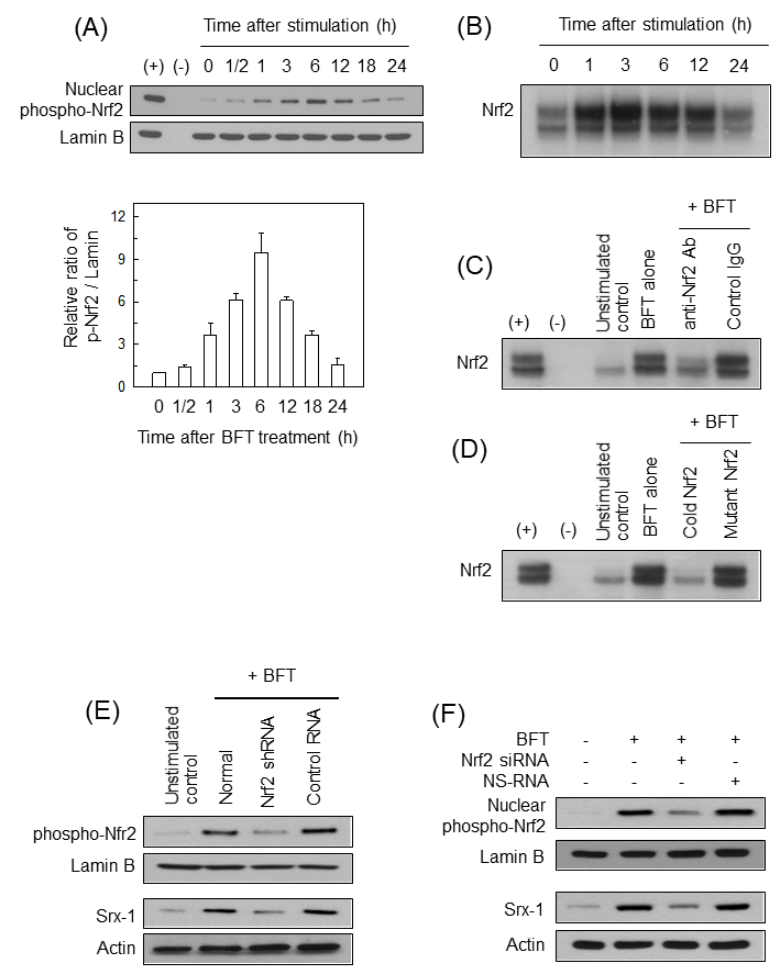
Figure 4. Effects of Nrf2-inhibition on Srx-1-expression in BFT-exposed HCT 116 cells. ( A ) BFT (300 ng/mL) was added to HCT 116 cells for the indicated periods of time. Nuclear protein expression of phospho-Nrf2 and lamin B was examined by western blot. Positive controls (+) were obtained from cells that were treated with 20 µM of sulforaphane for 2 h. Bottom panel shows densitometric analysis for expressed proteins. Values represent the relative densities of each protein compared with lamin B (mean ± SD, n = 3); ( B ) BFT (300 ng/mL) was added to HCT 116 cells for the indicated periods. Nrf2 DNA binding activity was assessed by EMSA; ( C ) HCT 116 cells were treated with BFT (300 ng/mL) for 6 h and nuclear extracts were obtained. Supershift assays using nuclear extracts were performed using anti-Nrf2 Ab and IgG isotype control Ab; ( D ) HCT 116 cells were treated with BFT (300 ng/mL) for 6 h. Nuclear extracts were added a 100-fold excess of the unlabeled probe (cold probe) or a mutant probe to the reaction, after which radiolabeled probes were added. After then, EMSA was performed identical to ( B ); ( E ) HCT 116 cells were transfected with shRNA against Nrf2 or control RNA. BFT (300 ng/mL) was added to each group for 6 h (phospho-Nrf2, top panels) or 18 h (Srx-1, bottom panels). Nuclear protein expression of phospho-Nrf2 and lamin B was determined by western blot. Concurrently, protein-expression of Srx-1 and actin was also evaluated by western blot; ( F ) HCT 116 cells were transfected with siRNA against Nrf2 or NS-RNA. BFT (300 ng/mL) was added to each group for 6 h (phospho- Nrf2, top panels) or 18 h (Srx-1, bottom panels). Analysis of protein- expression was identical to ( E ). All images are representative of more than three independent experiments.